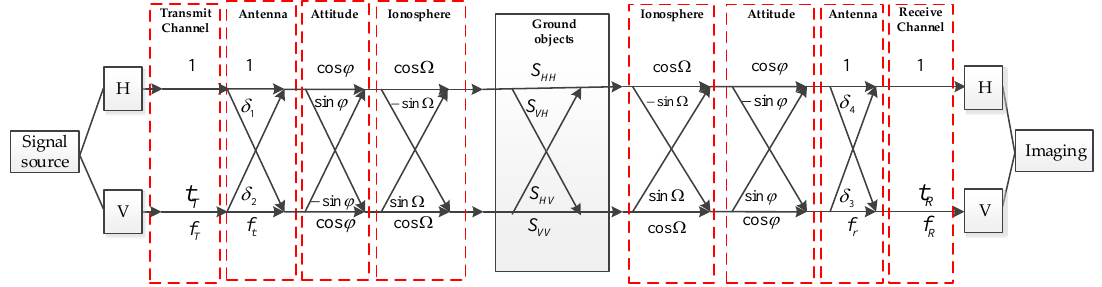
Figure 1. The entire propagation path of electromagnetic wave and the full-link error model for GF-3 PolSAR system.